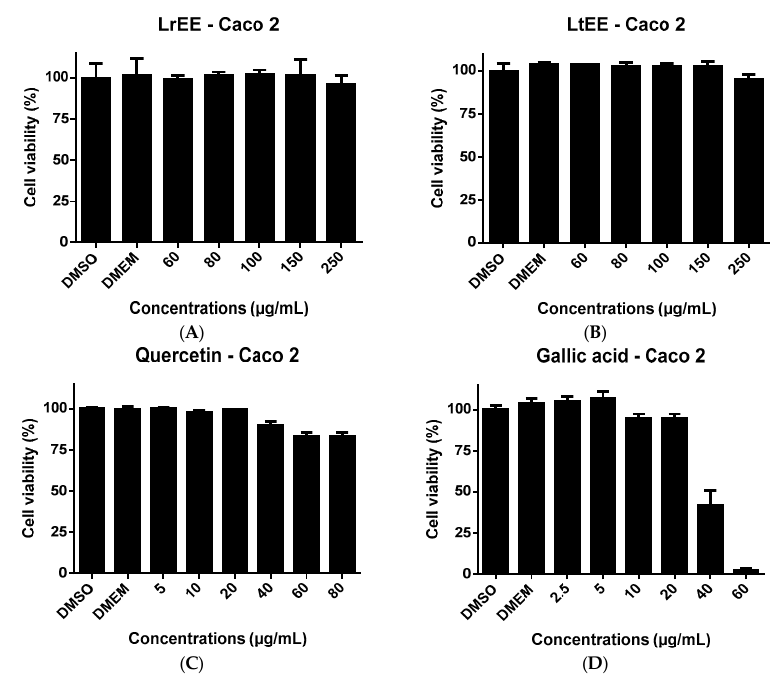
Figure 4. Cell viability of the human colon adenocarcinoma cell line Caco-2 upon 24 h exposure to ethanolic seeds extracts of Licania rigida ( A ); L. tomentosa ( B ); quercetin ( C ) and gallic acid ( D ). DMSO, dimethyl sulfoxide; DMEM, Dulbecco's Modified Eagle's Medium; LrEE, L. rigida ethanolic extract; LtEE, L. tomentosa ethanolic extract.